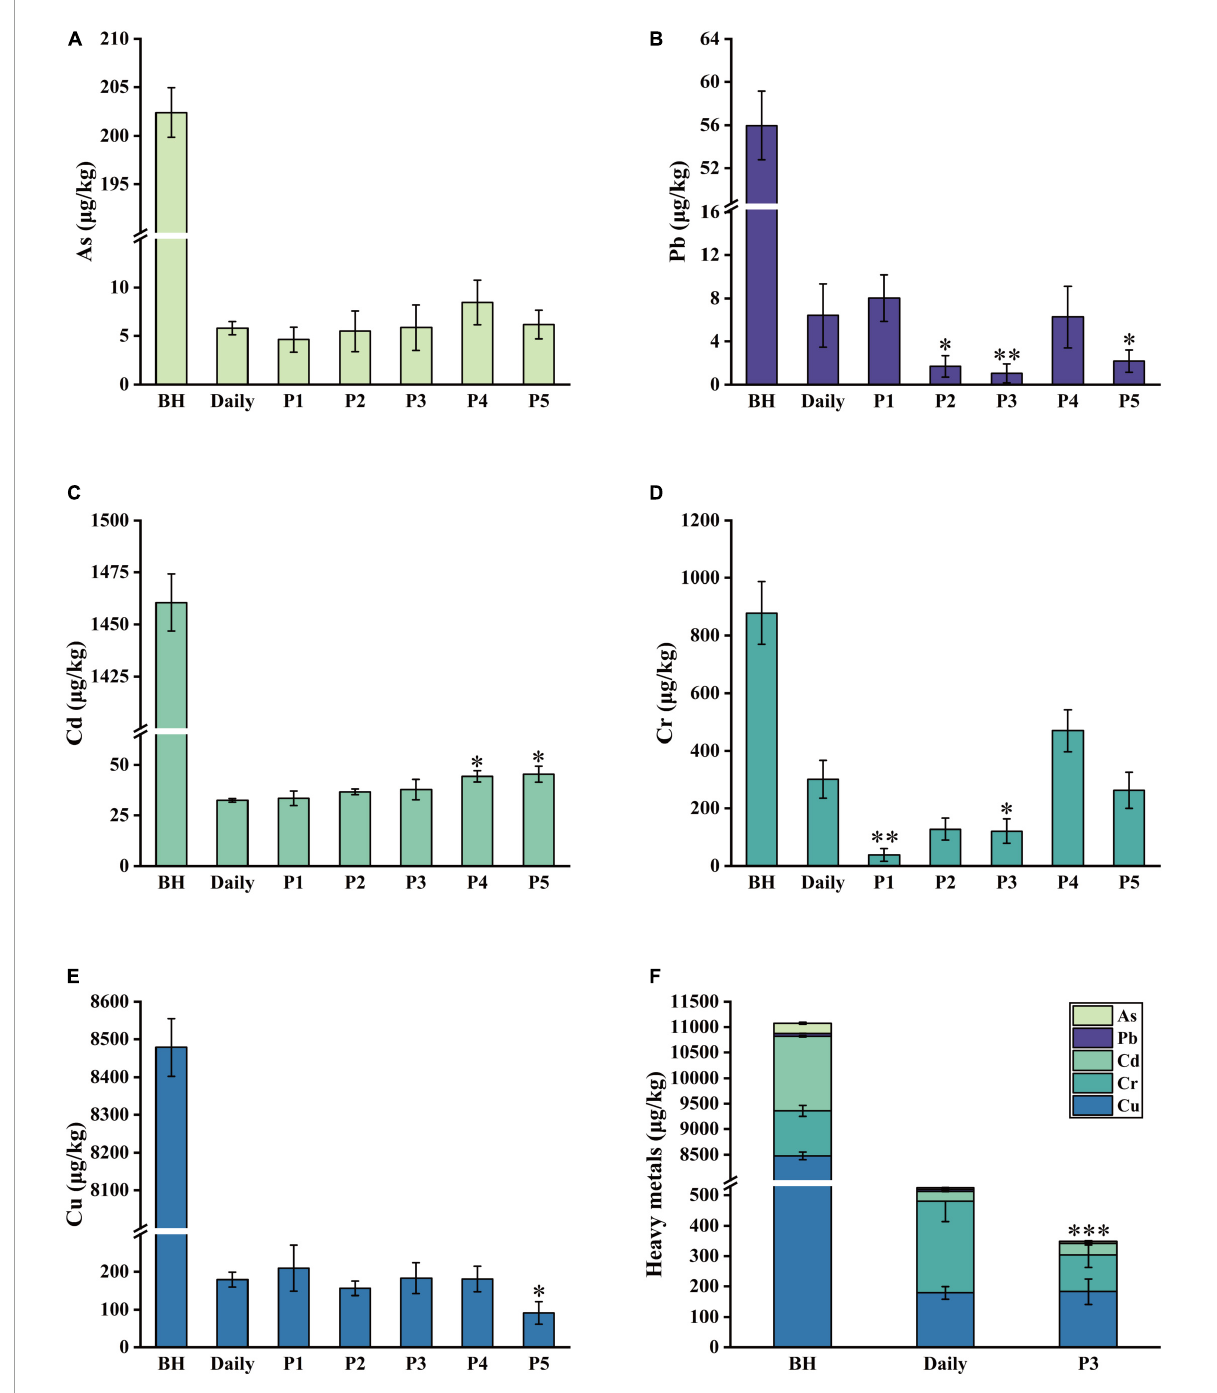
FIGURE2 Five heavy metals content in Lilii Bulbus and its soup. (A) As. (B) Pb. (C) Cd. (D) Cr. (E) Cu. (F) Total heavy metals content in the soup prepared by optimized process. BH, Lilii Bulbus ; Daily, Daily process; P1, Process 1; P2, Process 2; P3, Process 3; P4, Process 4; P5, Process 5. Significant differences between Daily and other processes (Student’s t -test): ∗ P < 0.05, ∗∗ P < 0.01, ∗∗∗ P <